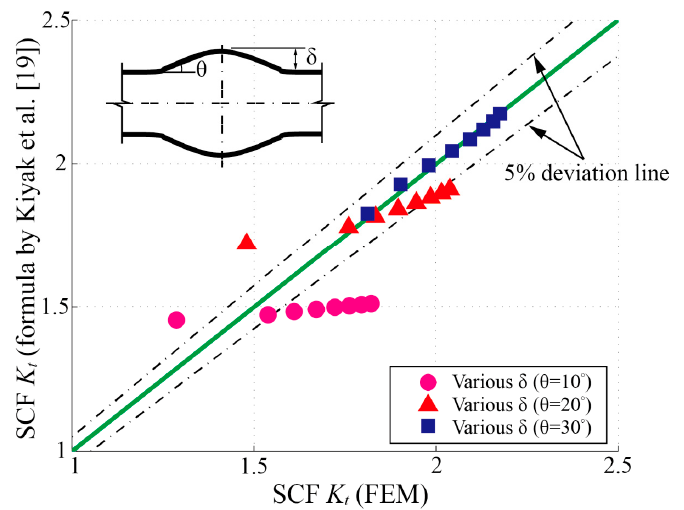
Figure 9. Comparison of the stress concentration factor (SCF) ( K t ) determined by finite element method (FEM) and the parametric formula in [19] under the small θ cases, reinforcement height: δ / t ∼ / 0.05 ~ 0.4 t δ = . s = 0.05 s